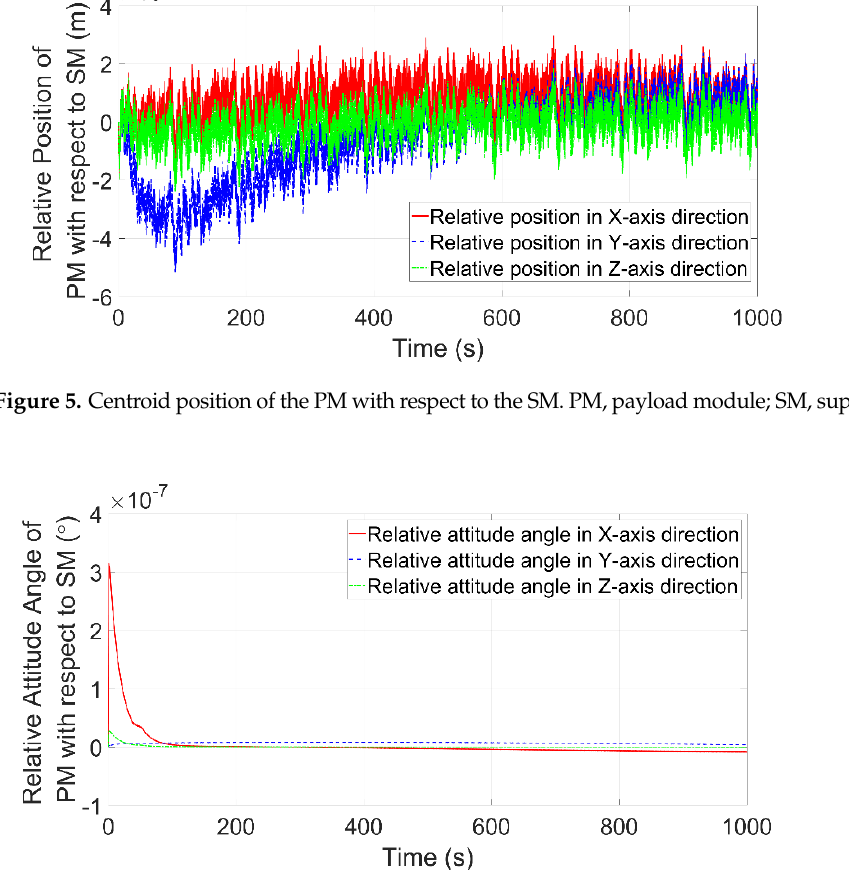
Figure 8. Attitude angle of the TM with respect to the SM. Figure 9 depicts the attitude angle of the SM, which shows the stability of the atti- tude-pointing control loop.